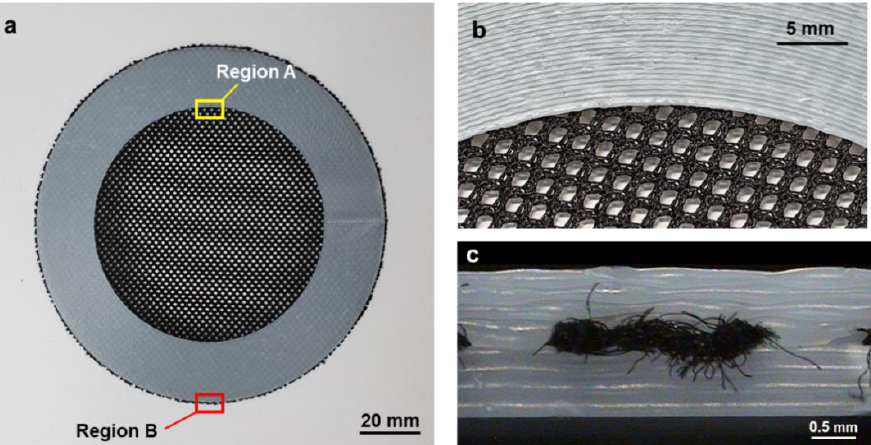
Figure 12. ( a ) Fabricated annular composite structure; ( b ) enlarged image of Region A (top view); ( c ) enlarged image of Region B (side view).